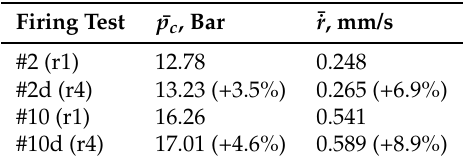
Table 10. Computed average results for Firing Tests #2 and #10 with the effect of a change in the pyrolysis law data (r1 vs. r4), Cases #2d and